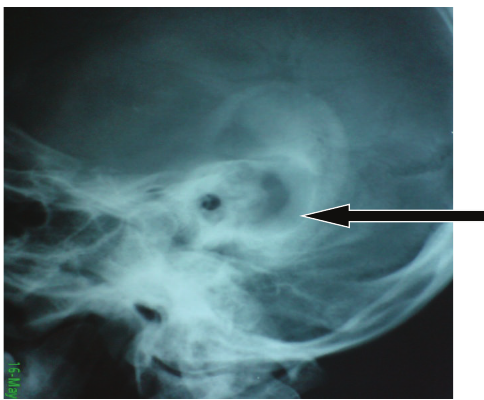
Figure 1: Opacification and large mastoid cavity as seen in the patient’s X-ray mastoid.